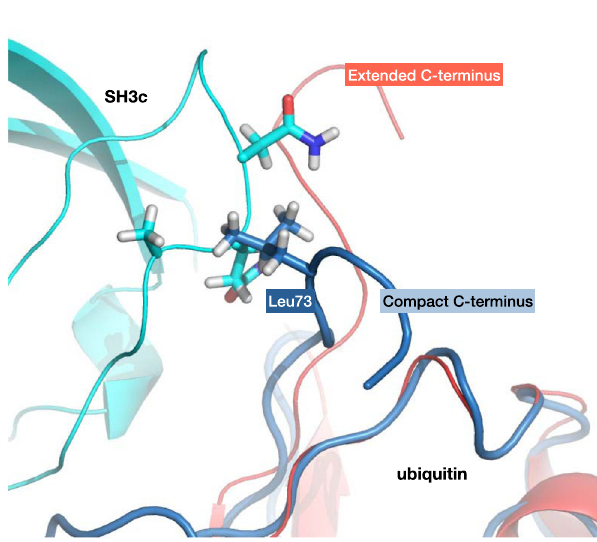
Fig. 4 Compact C-terminal ubiquitin conformation sterically obstructs binding to SH3c via the ubiquitin Leu73 sidechain. Superposition of compact C-terminal ubiquitin conformations from simulations (blue) on the experimental ubiquitin:SH3c model (pdb: 2k6d, red and cyan) show steric clashes between ubiquitin Leu73 and the SH3c